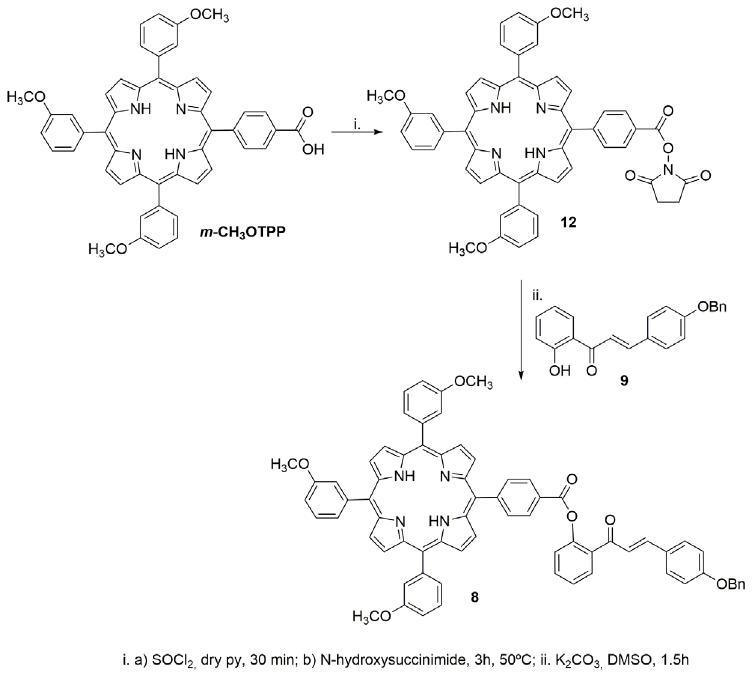
Figure 14 - Synthesis of chalcone-porphyrin derivative